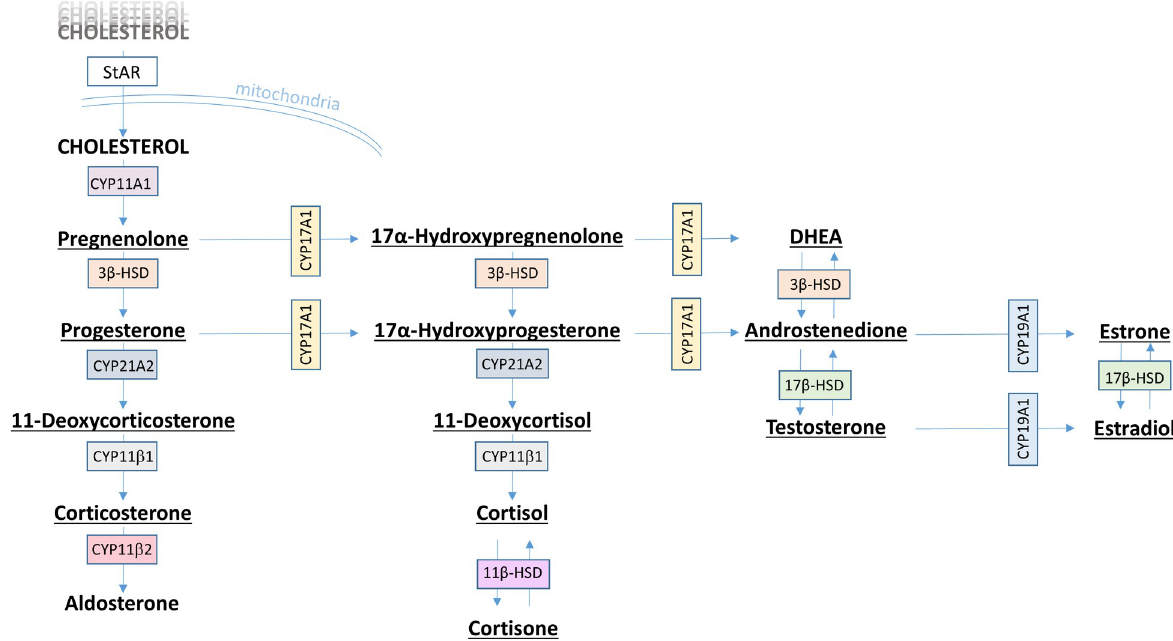
Fig 1. Steroidogenesis pathway. Steroidogenesis pathway, including hormones and enzymes involved [32]. The 14 hormones analysed in this study are underlined.